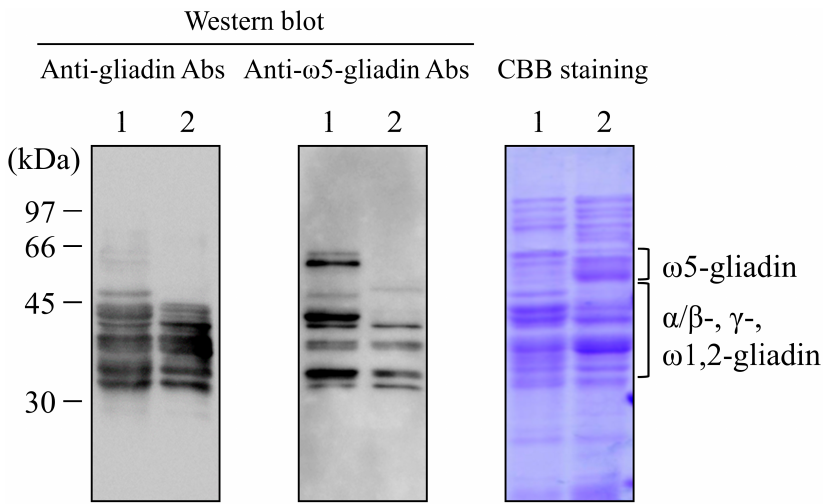
Figure 2. Western blot analysis of the gluten from two wheat cultivars. Gluten (10 µ g) from Hokushin (lane 1) and 1BS-18H wheat (lane 2) was separated by SDS-PAGE and blotted onto a PVDF membrane. The membrane was incubated with anti-gliadin Abs and anti- ω 5-gliadin Abs. For CBB staining, 25 µ g of each gluten was loaded onto the